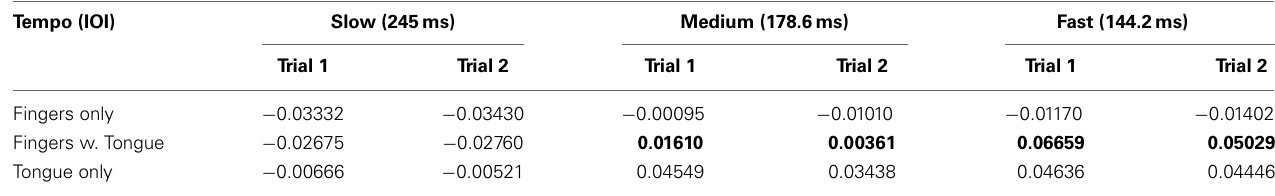
Table 1 | Timing error for both trials of sequences performed with different effectors in three tempo